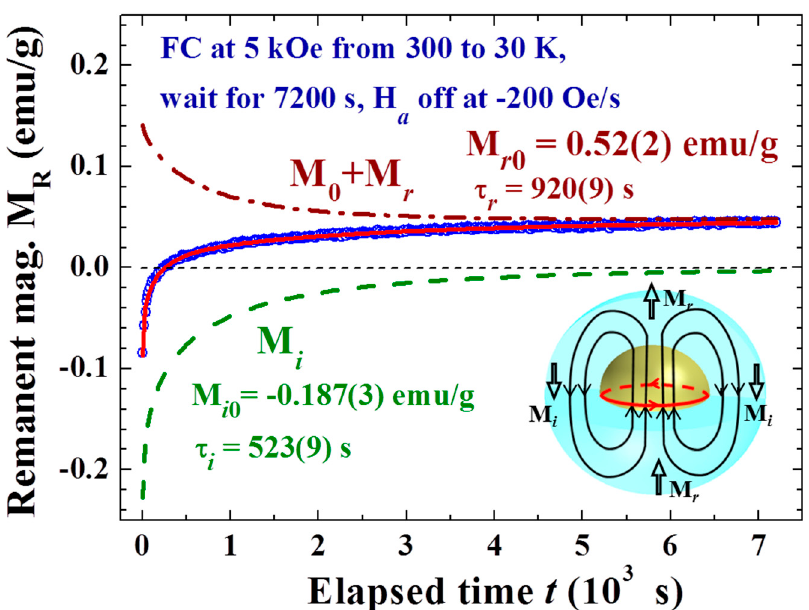
Figure 7. Time evolution of the remanent magnetization recorded after field-cooling at H a = 5 kOe from 300 to 30 K, followed by a wait for 7200 s before turning off the H a at a rate of − 200 Oe/s. The solid lines indicate the fit of the data to the reduced exponential decay profile discussed in text. The dot-dashed curve in the upper panel indicates the final magnetization M 0 plus the residual magnetization M r . The dashed curve in the lower panel indicates the induced magnetization M i . The inset shows a schematic representation of the Faraday induced current and magnetic field shortly after H a reaches zero, where the eddy current in the Ni shell has dissipated, while that in the Au core (with a lower resistivity) is still circulating to produce an inverse magnetic field H i .